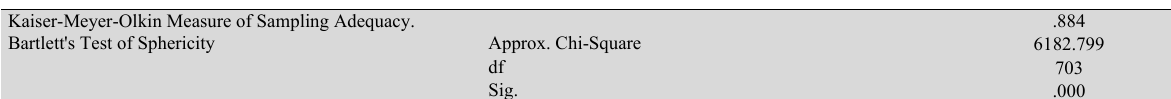
Source: SPSS22 Analysis Results